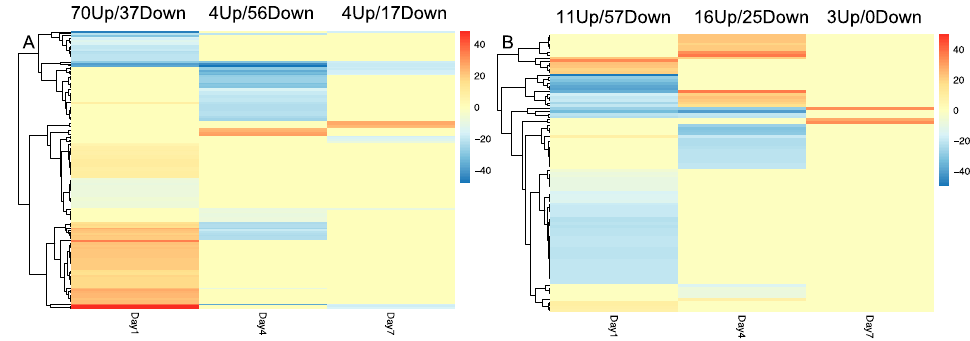
Figure 7. Heatmap of DEG on chromosome P9 between inoculated and uninoculated samples for each cultivar at 1, 4, and 7 days post-inoculation. ( A ): resistant cultivar; ( B ): susceptible cultivar. Up(red) and Down(blue) regulated genes are those with significantly higher and lower expression in inoculated samples, respectively. The number of the legend indicates log2 fold change. Table 1. Select directionally DEG located within chromosome P9.